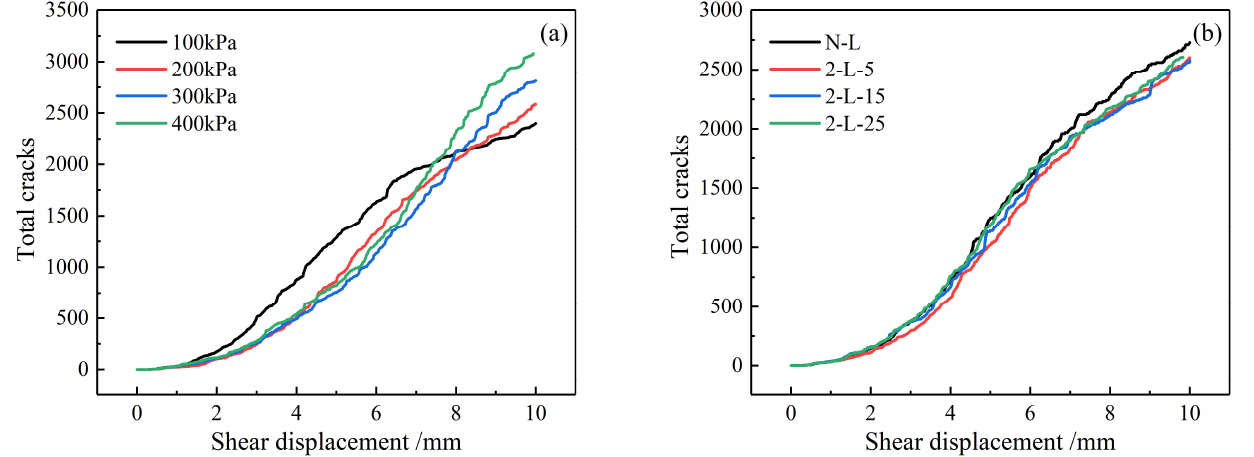
Figure 15. Total number of micro-cracks: ( a ) 2-L-25; ( b ) 100 kPa normal